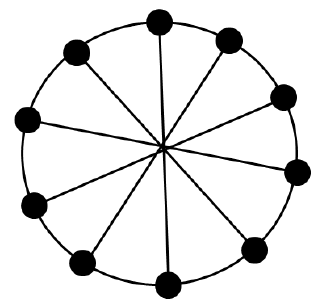
Figure 9. Graph with ten vertices possessing a transitive group and ten line